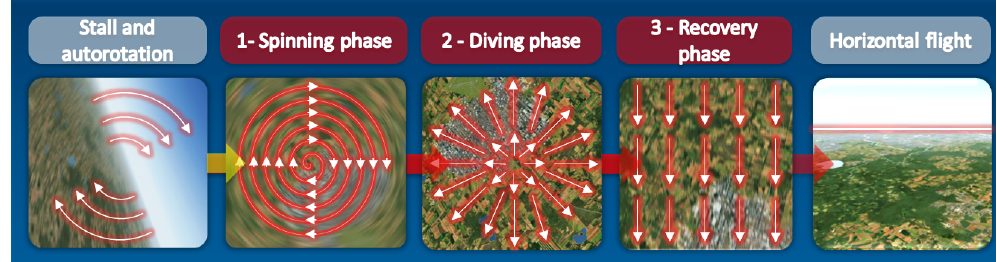
Figure 2. Keypoints displacements in diffrent